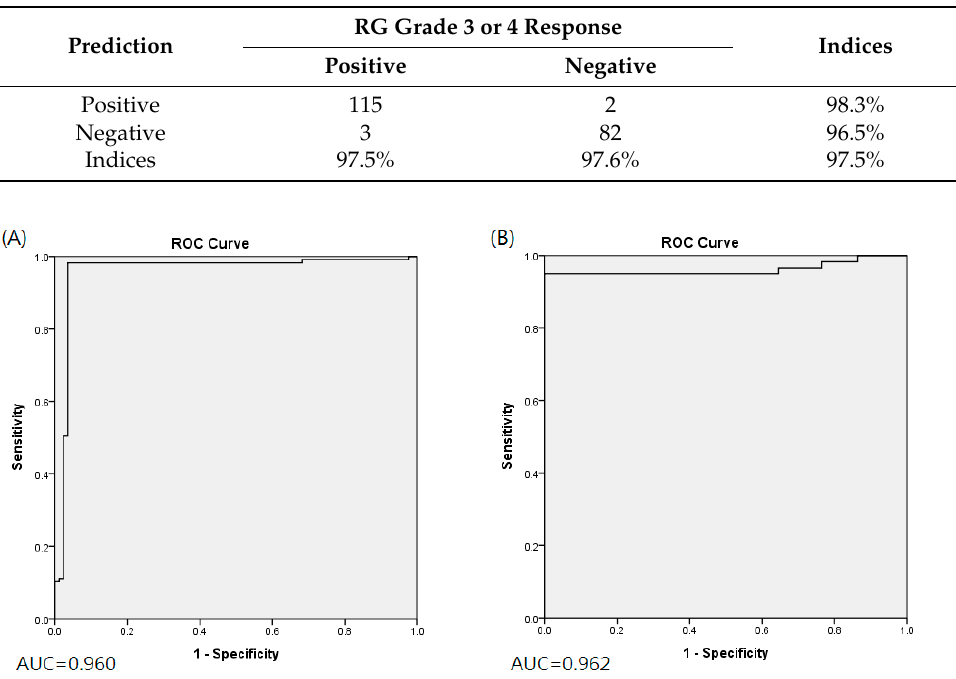
Figure 2. Area under ROC curve for training cohort ( A ) and validation cohort ( B ).